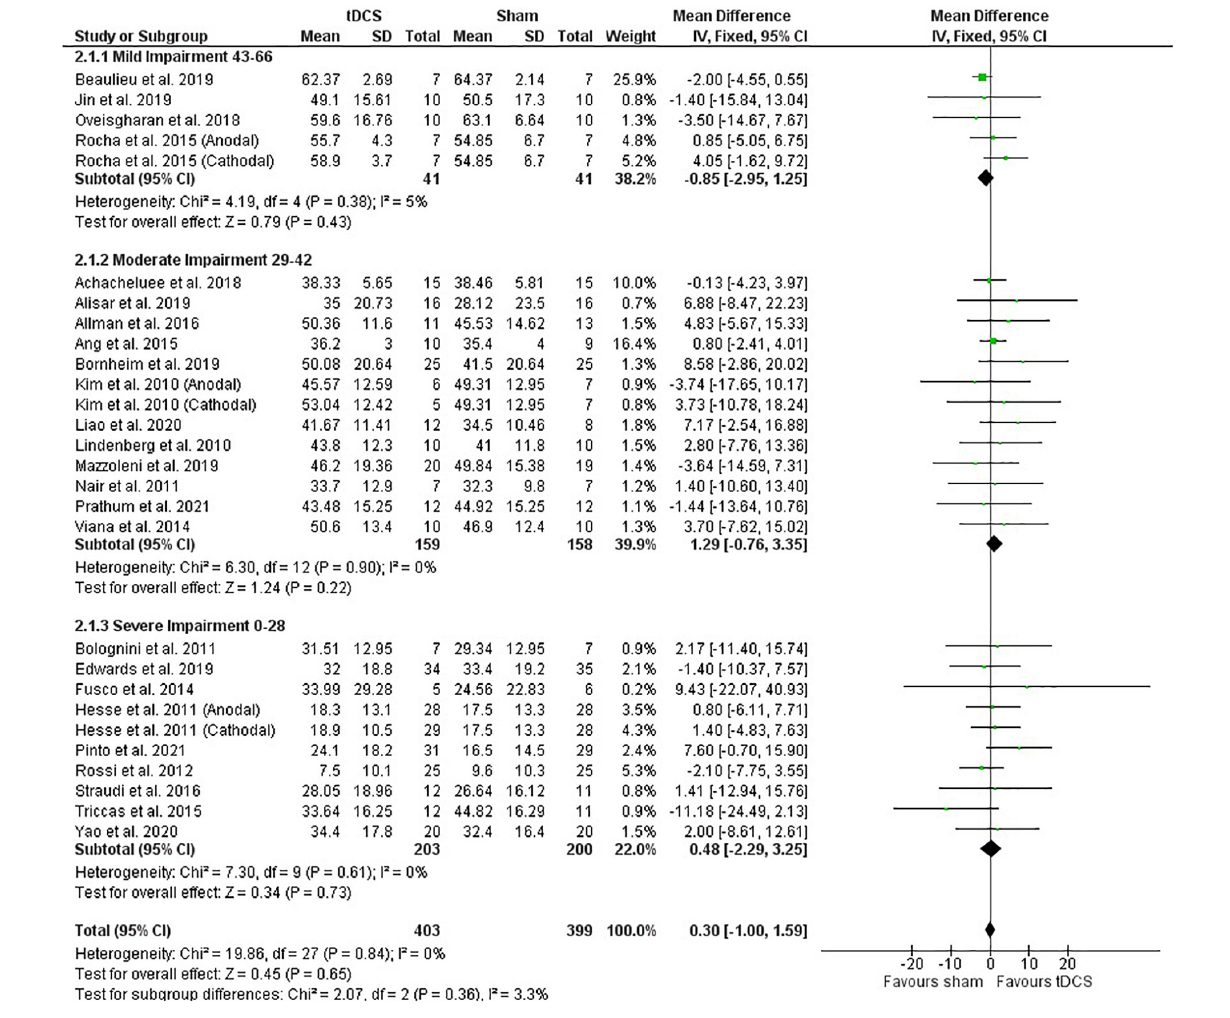
the cathodal stimulation (sham: 75 vs. tDCS: 73), and 246 participants in the bihemispheric stimulation (sham: 121